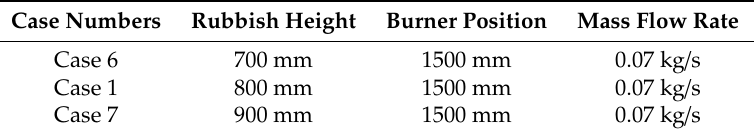
Figure 15. Velocity contours inside the incinerator for the place of installation of the primary burner (m/s).